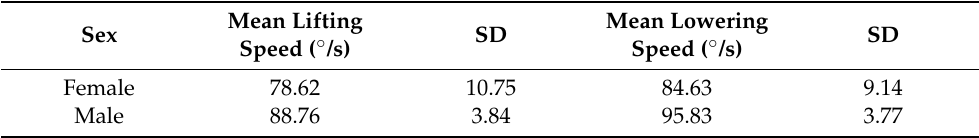
Table 3. Evaluation of mean lifting and lowering speeds for different weights by gender. Instanta- neous velocities exhibited a stable trend, with little variation seen between